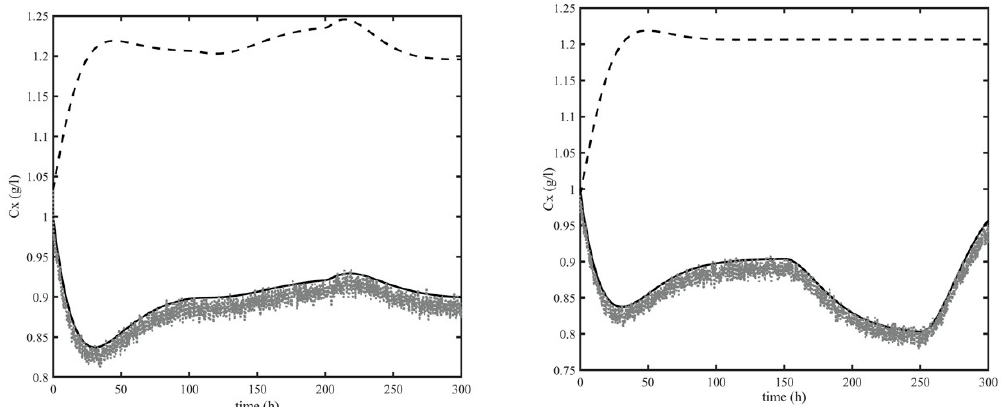
Figure 3. Dynamic response of biomass concentration calculated with the virtual plant (continuous line), open-loop model (dashed line) and GO (dotted grey line) for structure φ 2 along trajectory T1 ( left panel) and T2 ( right panel).